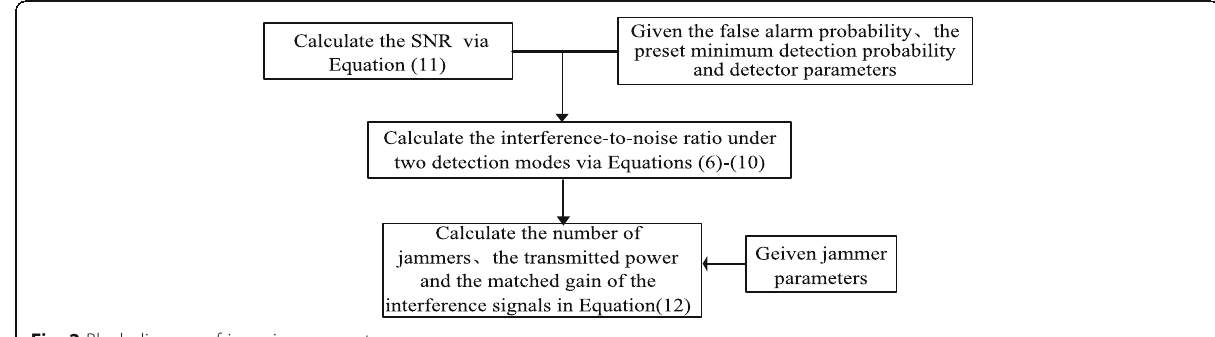
Fig. 2 Block diagram of jamming